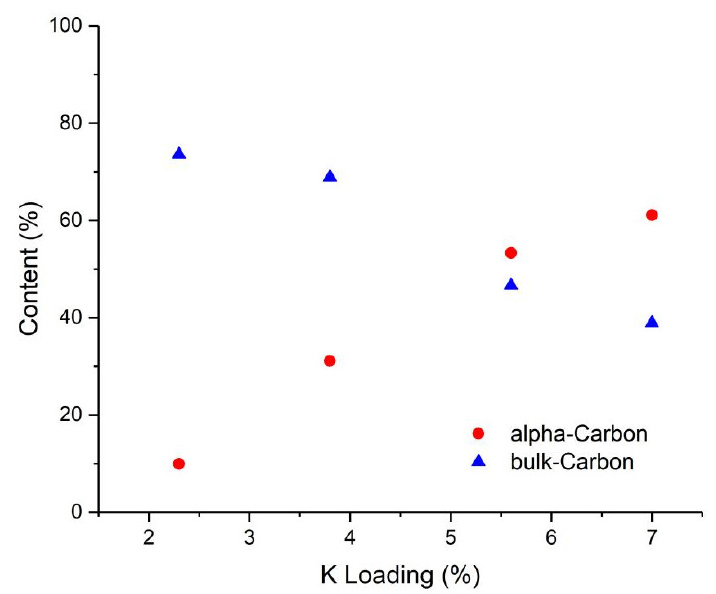
Figure 8. Relationship between reactive carbon and bulk carbide carbon contents with K loading.